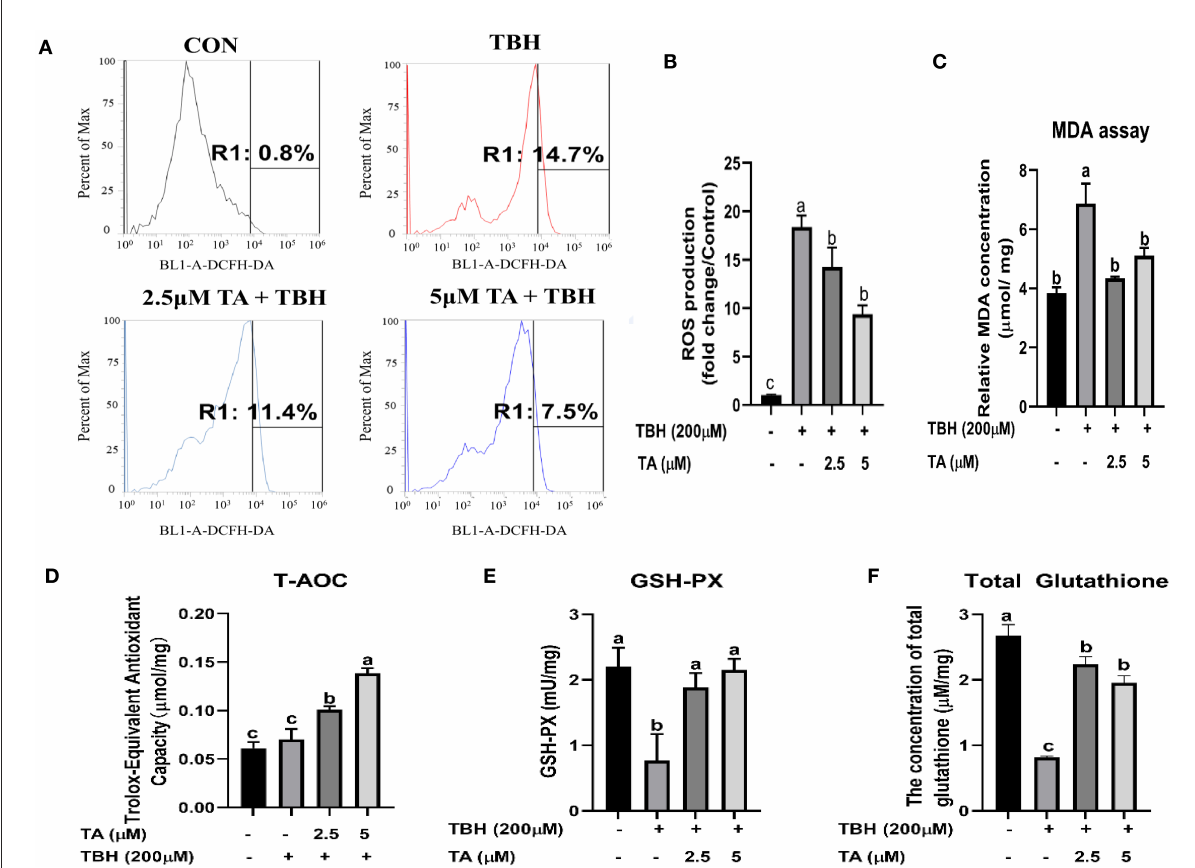
FIGURE4 Effects of tannic acid (TA) on the redox state of IPEC-J2 cells. IPEC-J2 cells were treated with indicated doses of TA for 12h followed by TBH (200 µ M) for 3h. Flow cytometry analysis data of the cellular ROS levels are shown in a gate information (A) . Quantification of the cellular ROS levels from flow cytometry data (B) . The concentration of the cellular MDA (C) and total glutathione (F) and the antioxidant enzyme activities of T-AOC (D) and GSH-PX (E) were determined. Data are presented as mean ± SEM, n = 3. TA, tannic acid; TBH, tert-butyl hydroperoxide. a,b values in the same row not sharing a common superscript differ